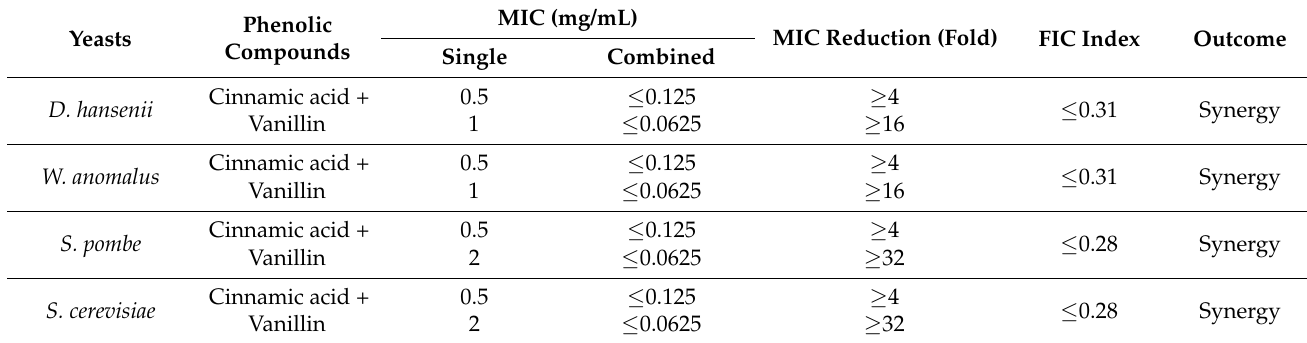
Table 1. Effect of combination of vanillin and cinnamic acid on planktonic growth of food spoilage yeasts.